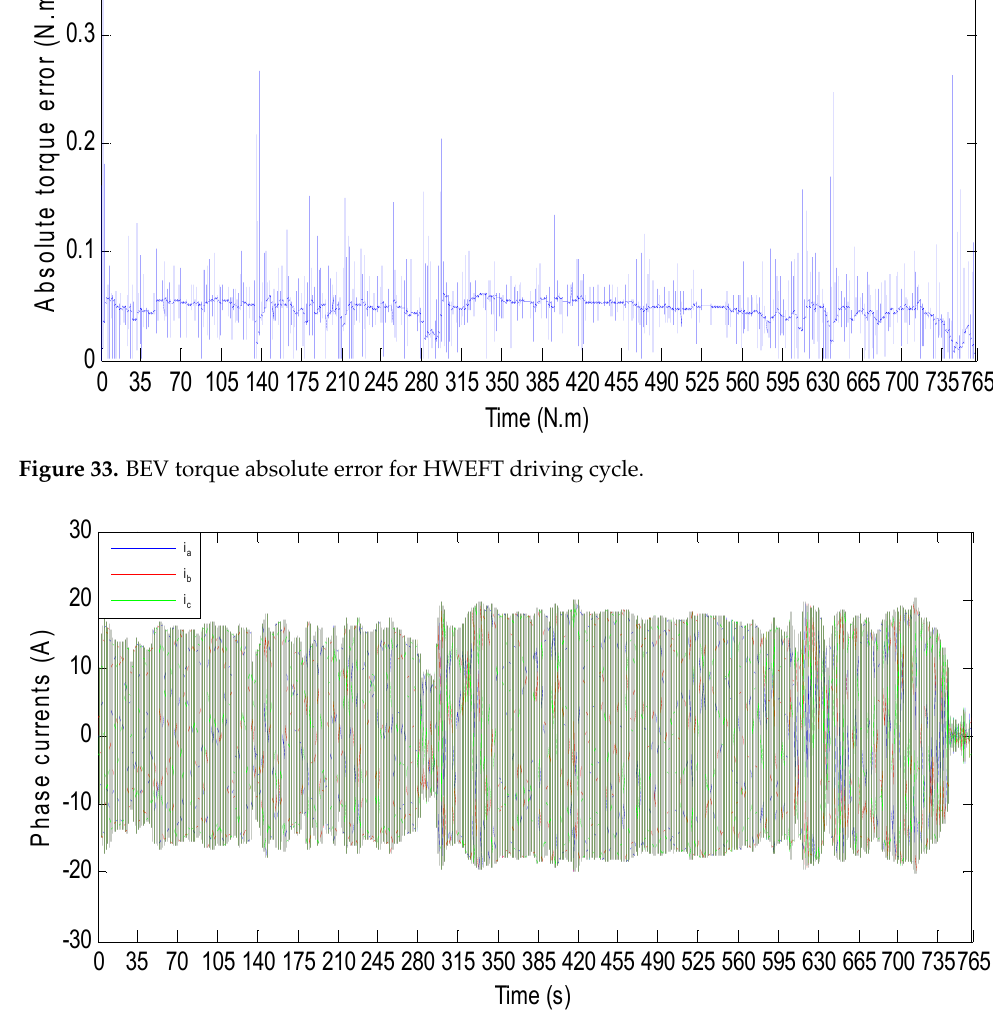
Figure 34. PMSM phase currents for HWFET driving cycle.